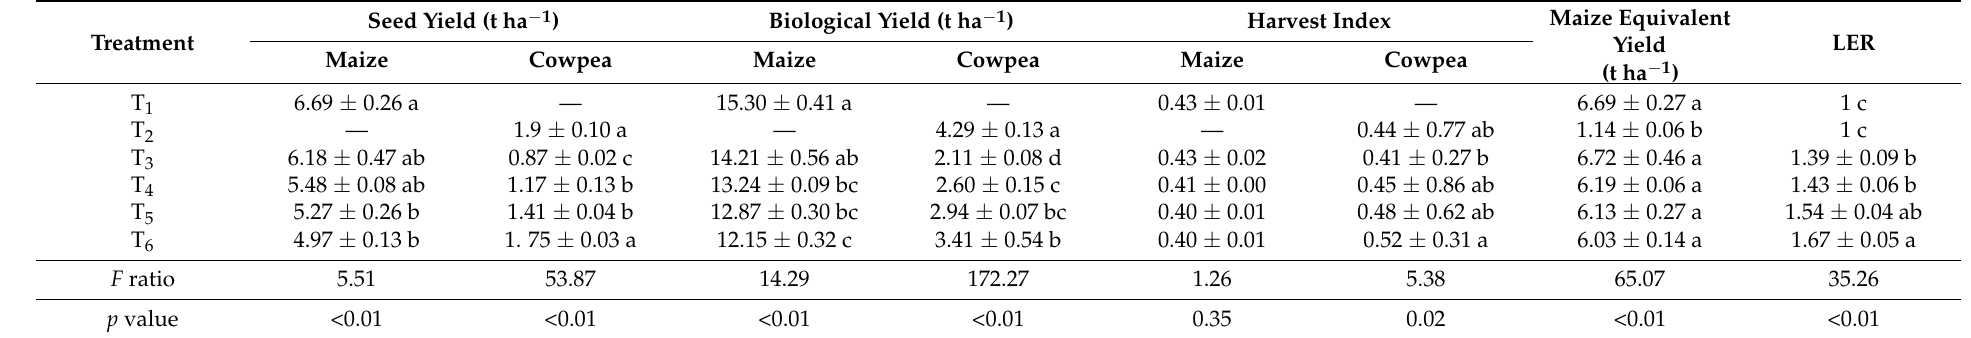
Table 5. Yield performance of maize-cowpea grown (means ± SE, N = 3) under different practices. Treatment